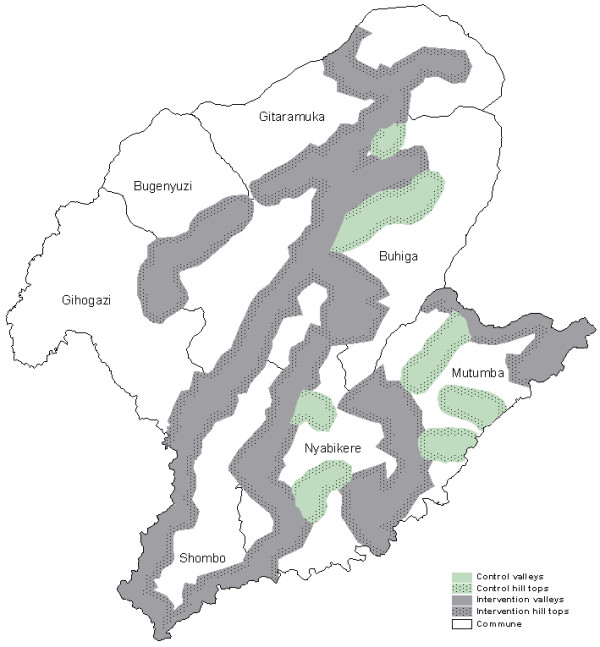
Map of Karuzi Province (Burundi) showing the intervention and control areas. In the intervention areas only the valleys were sprayed depicted in grey. The hill tops were not sprayed (dotted grey). The control areas are represented in green for the valleys and dotted green for the hill tops.